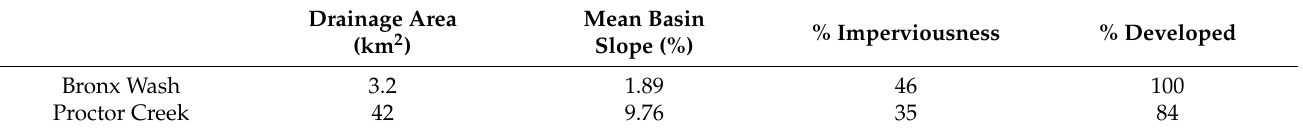
Figure 1. Model study sites: ( a ) Proctor Creek, Atlanta, GA, USA; ( b ) Bronx Wash, Tucson, AZ, USA. Table 1. Study site characteristics.